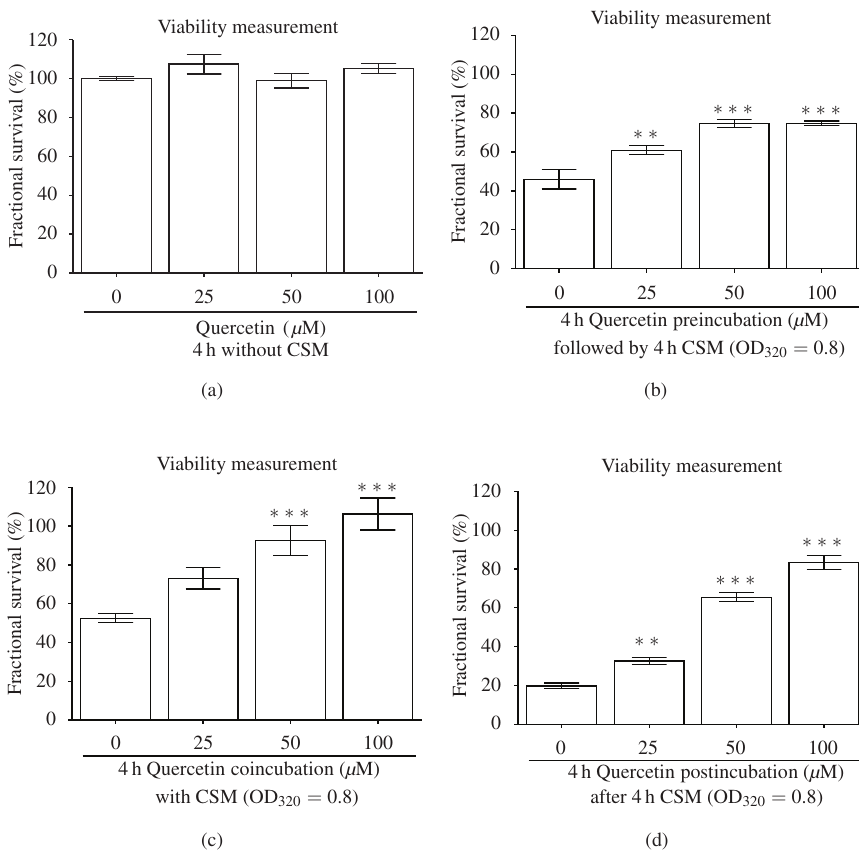
FIGURE 3: Quercetin reduces CSM-induced cellular damage in primary human osteoblasts dose- dependently. (a) Stimulation of primary human osteoblasts ( N = 3 , n = 4 ) for 4 h with 25, 50, and 100 μ M Quercetin is not toxic to the cells. (b) Pre-, (c) co-, and (d) postincubation with these subtoxic concentrations of Quercetin protects primary human osteoblasts ( N = 3 , n = 4 ) from CSM-induced (OD 320 = 0.8) cellular damage. Viability was measured by resazurin conversion. Results are given as fractional survival [ % ] compared to untreated cells. ∗∗ P < 0 . 01 , ∗∗∗ P < 0 . 001 compared to CSM-treated